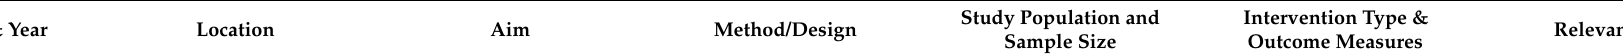
Table 3. Characteristics of included